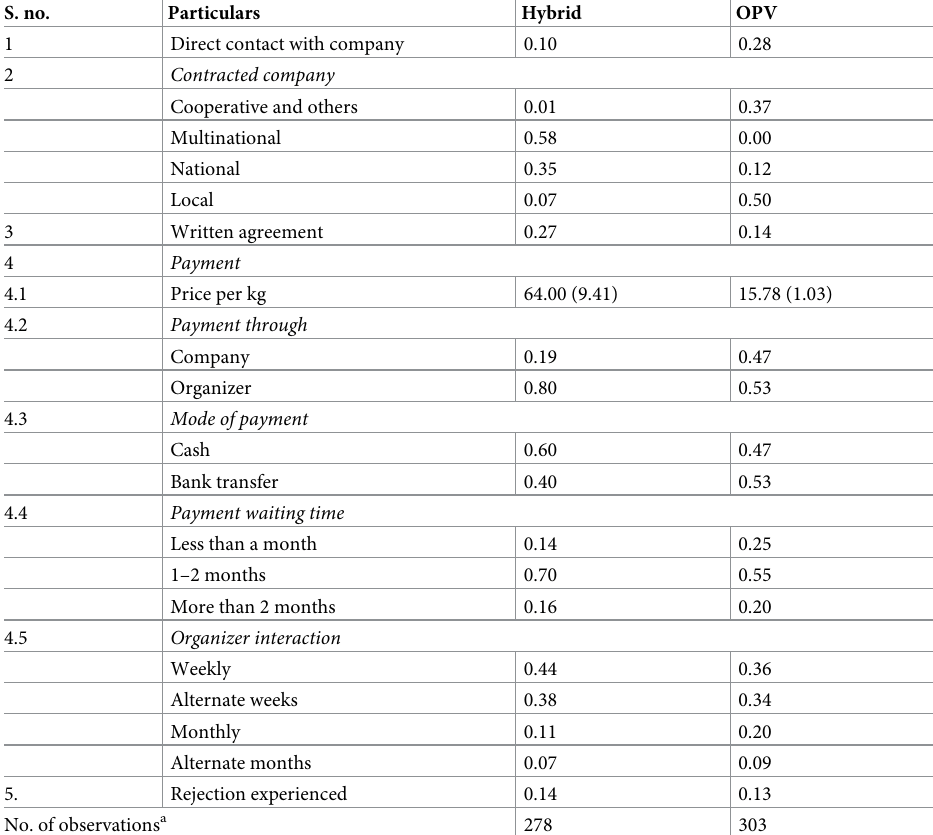
Table 1. Seed contract characteristics in the study